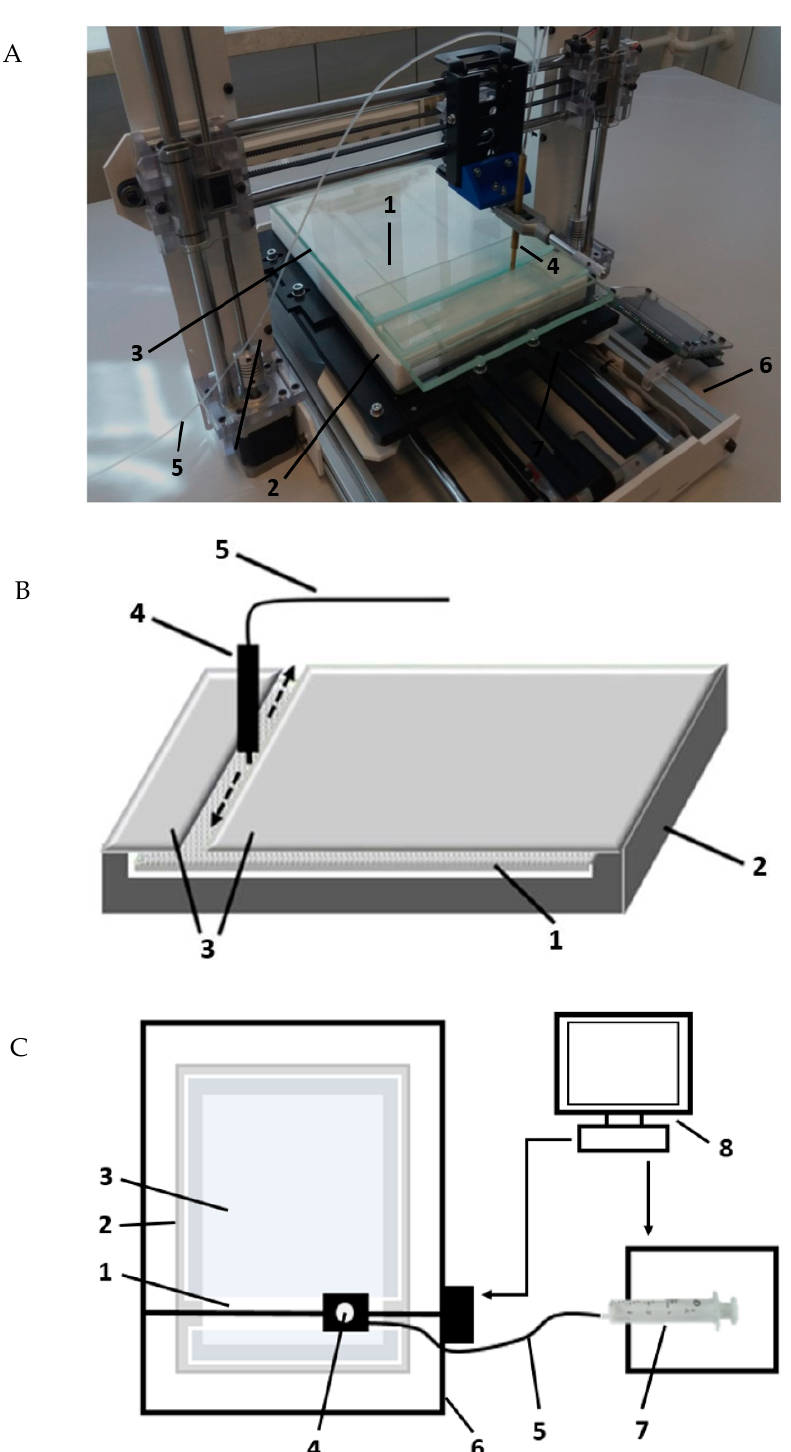
Figure 6. ( A ) The picture of the prototype device. ( B ) Axonometric view of the horizontal chamber with moving pipette. ( C ) Conceptual view of the whole device, 1—chromatographic plate, 2—Teflon horizontal TLC chamber, 3—cover glass plate, 4—moving pipette, 5—capillary, 6—3D machine, 7—syringe pump, 8—computer.